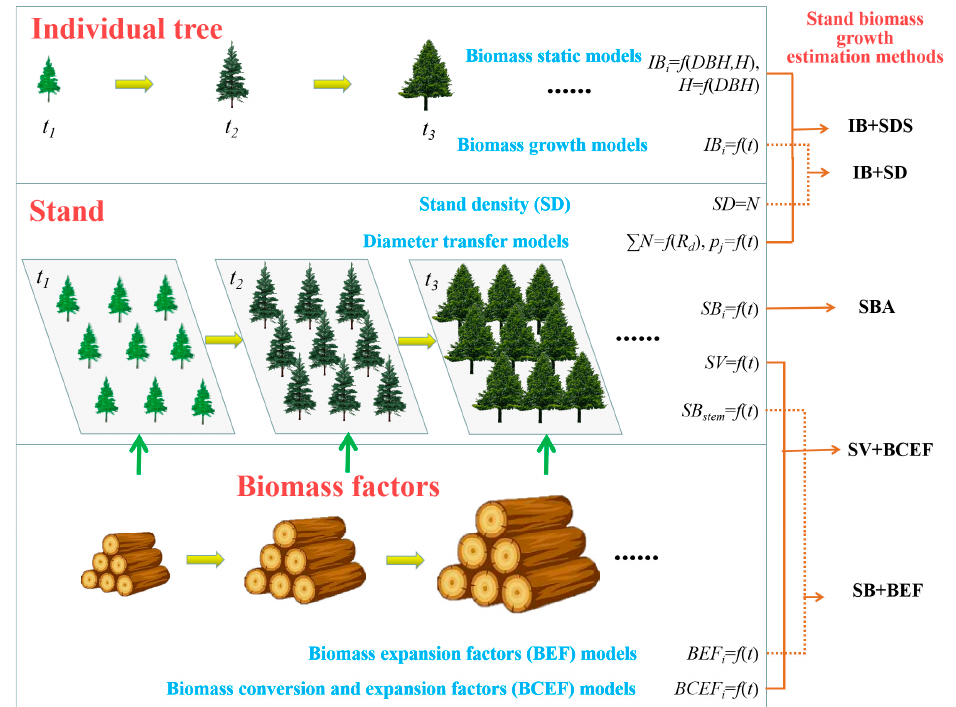
Figure 1. The list of stand biomass growth estimation models. SBA is a direct estimation using stand biomass of the components; SB+BEF is an estimation method using stand stem biomass incorporating BEF i ; SV+BCEF is an estimation method using stand volume incorporating BCEF i ; IB+SDS is an estimation method using static biomass of the components for individual tree incorporating dynamical estimation on stand diameter structure; IB+SD is an estimation method using biomass growth of the components for individual tree incorporating stand density. Furthermore, IB i is the i -th components biomass of individual tree; SB i is the i -th components biomass of stand; BEF i is the biomass expansion factors of the i -th components based on stem biomass of stand; BCEF i is the biomass conversion and expansion factors of i -th components biomass based on stand volume; SV is the stand volume; DBH is the diameter at breast height; R d is the diameter classes; t is the age of the tree or stand; SD is the stand density (trees · ha − 1 ); N is the cumulative probability of the diameter classes from minimum class; p j is the estimation of the cumulative probability distribution functions for fitting the stand diameter